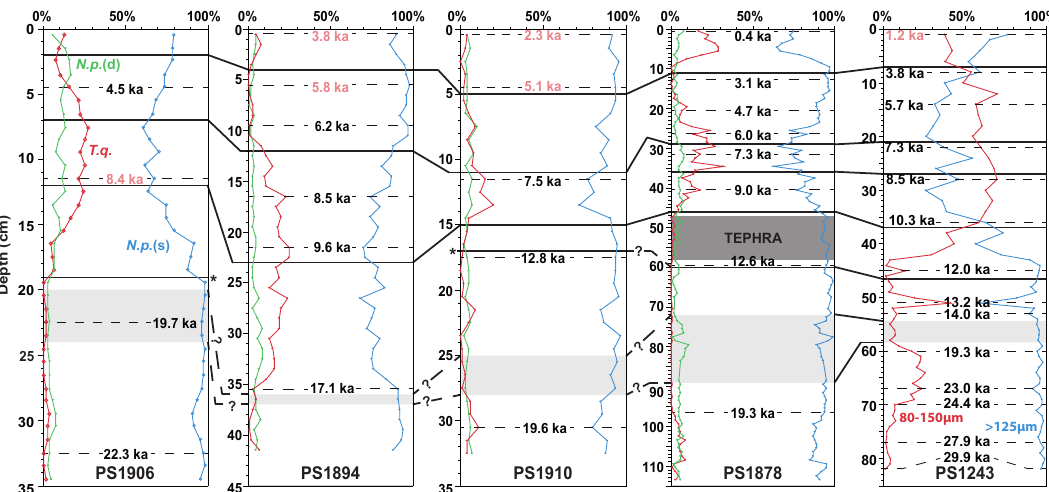
Fig. 4. Relative abundances of the three most common planktic foraminifera species in cores used in this study and core PS1243. N.p. (s) – N. pachyderma (sin.), N.p. (d) – N. pachyderma (dex.), T.q. – T. quinqueloba . Correlation and ages as in Fig. 2. Note the different size fractions used in core